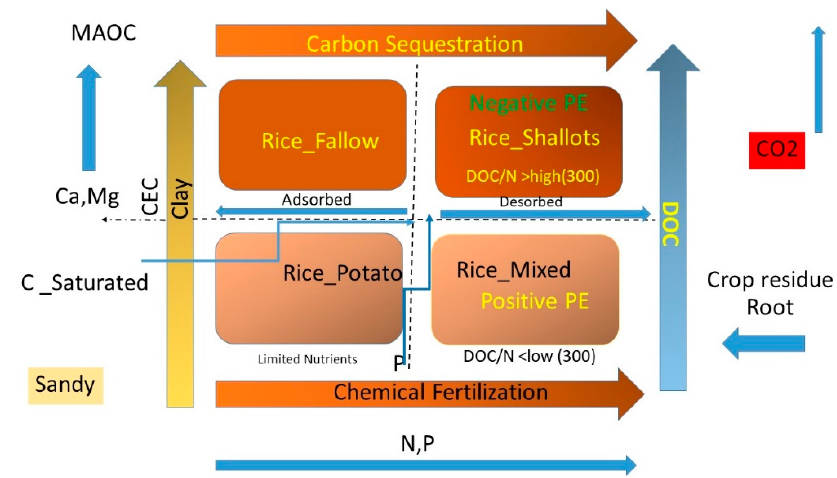
Figure 10. The relationship between the driving factors and effects on SOC storage of the RRCS.